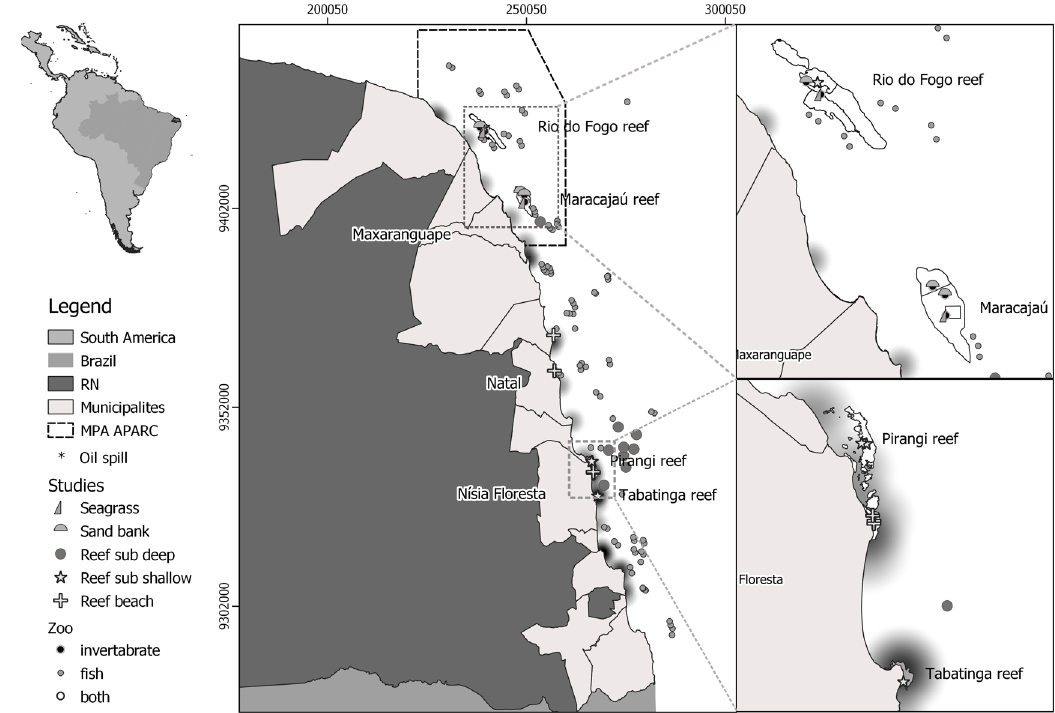
Figure 1. Overlay map of the sample sites and oil spill at study area: invertebrates sampled (black dots), fishes sampled (gray dots) and both (white dots). All Studies Habitat are represented by geometric symbol. Oil spill are represented in black stains with a spreading radius of 3,8 km (merely